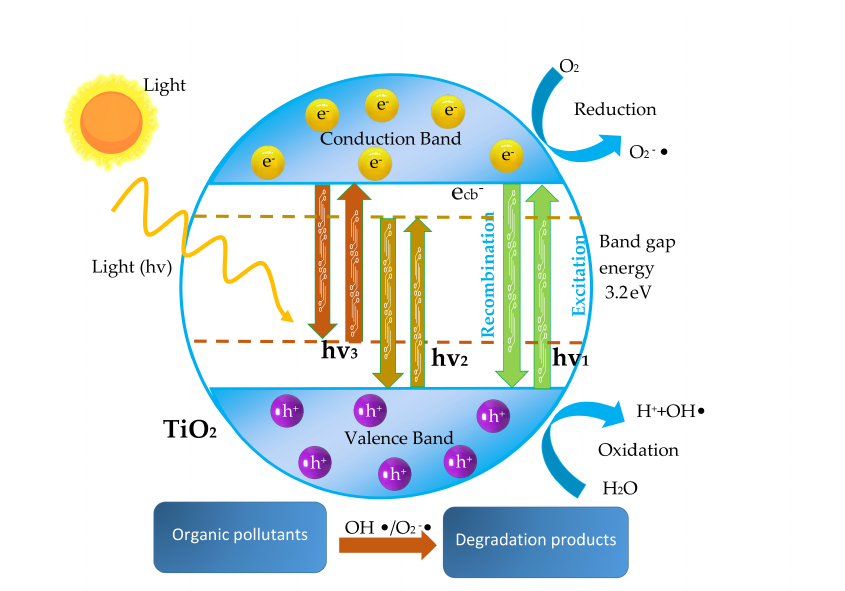
Figure 2. Mechanism of TiO 2 photocatalysis—hv 1 : pure TiO 2 ; hv 2 : metal-doped TiO 2 , and hv 3 : non-metal-doped TiO 2 .